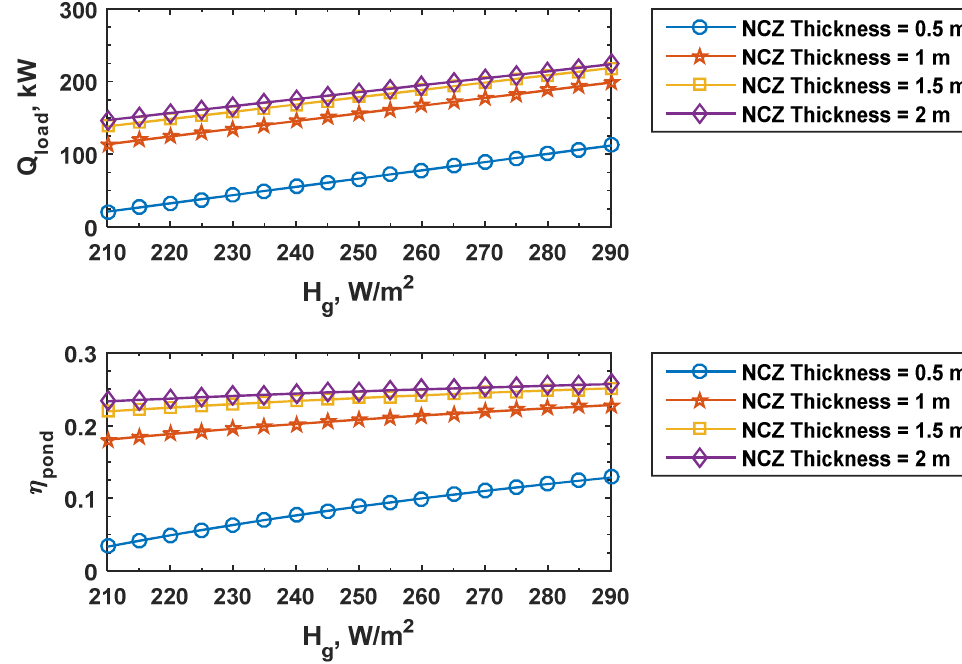
Figure 5. Effect of annual average global radiation on the performance of the pond.